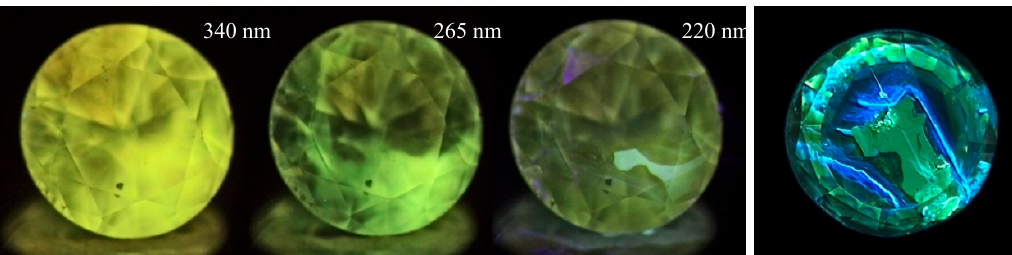
Figure 10. A brown CO 2 diamond (sample TH 2.69) under three different UV excitations of the DFI system. The yellow to yellow green PL is caused mainly by the S1 defect. The fluorescence is concentrated to the brown CO 2 -rich zones. The image on the far right shows sample TH 2.71 that was cut into platelet, under the DiamondView TM system.